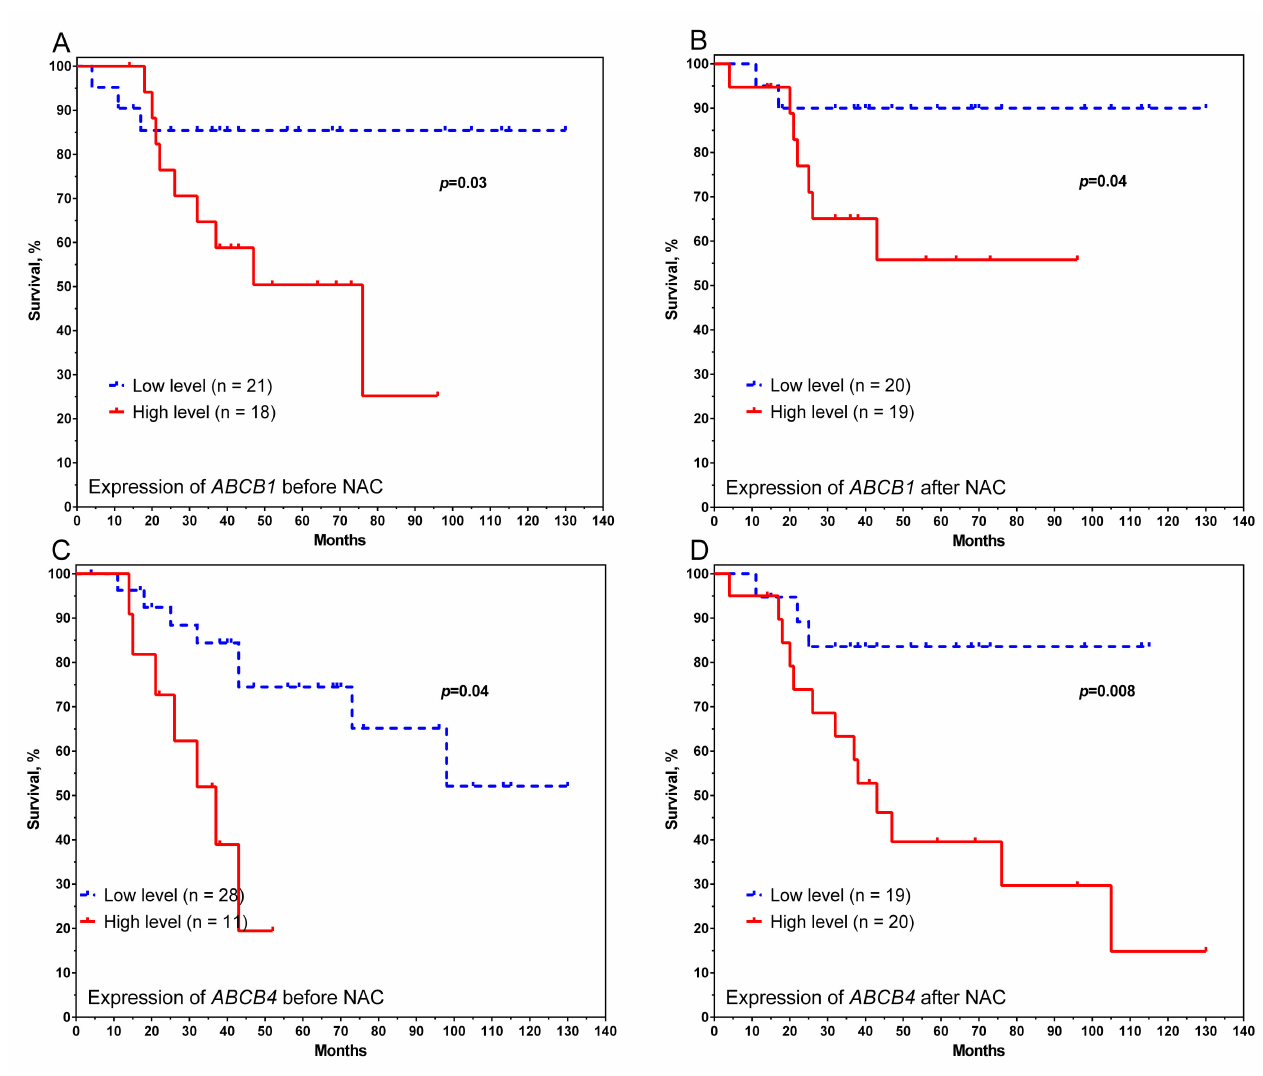
Figure 2. Curves of metastatic survival of patients with breast cancer, depending on the level of ABCB1 gene expression before ( A ) and after ( B ), and ABCB4 before ( C ) and after ( D ). Note: the median expression was used as a grouping variable; for ABCB1 before treatment, 6.06; for ABCB1 after NAC, 7.4; for ABCB4 before treatment, 6.62; for ABCB4 after NAC, 9.46. Low initial expression levels of the genes ABCC5, ABCC9, ABCD3 , and ABCG1 statisti- cally significantly contributed to high survival rates (Figure 3A–D). The 5-year metastatic- free survival rate was 80% for ABCC5 , 73% for ABCC9 , 76% for ABCD3 , and 76% for ABCG1 in the low-gene-expression group and 32% for ABCC5 , 44% for ABCC9 , 43% for ABCD3 , and 45% for ABCG1 in the high-gene-expression group (log-rank test p = 0.004, p = 0.02, p = 0.02, p = 0.02,